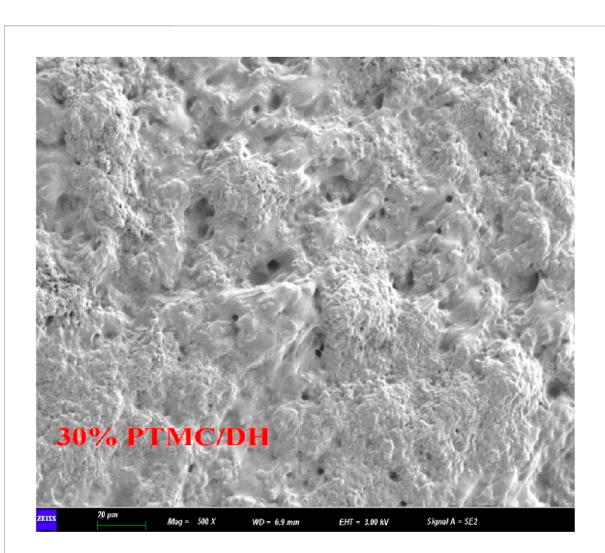
FIGURE 5 SEM images after hydrolysis of drug-loaded fi lms at different